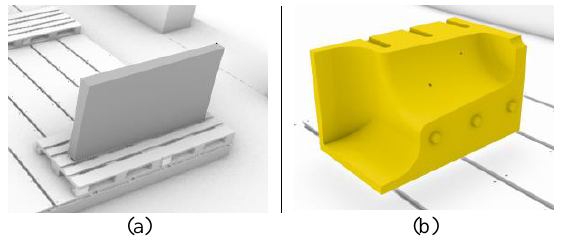
Figure 7 . Two as-designed model objects in the fabrication lab. (a) shotcrete wall, and (b) wax